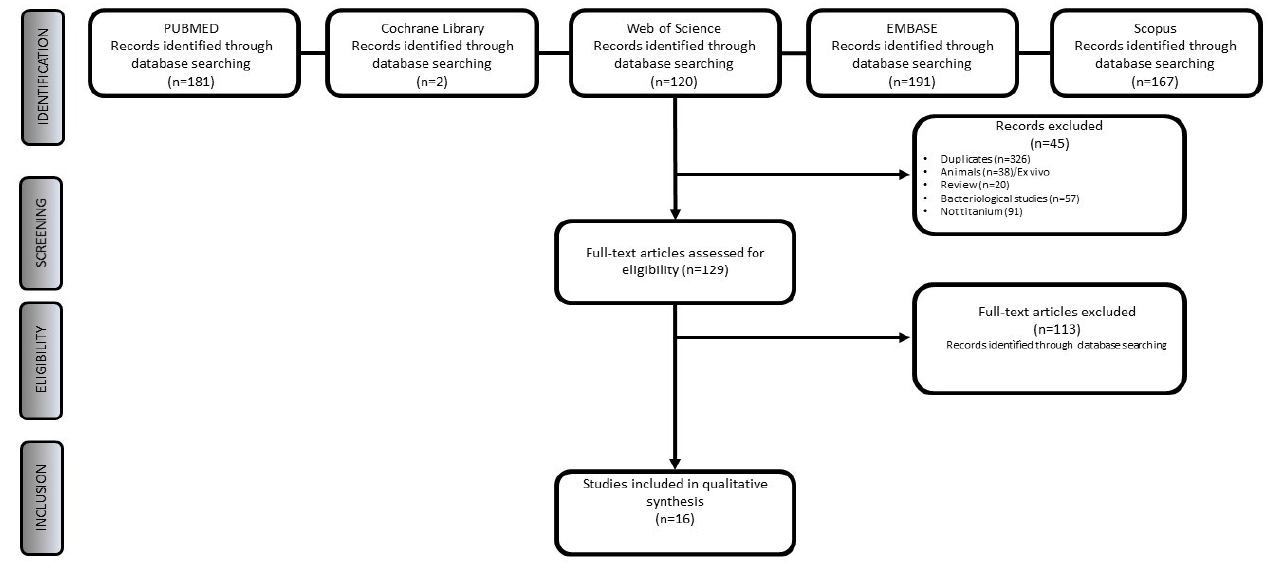
Figure 1. PRISMA